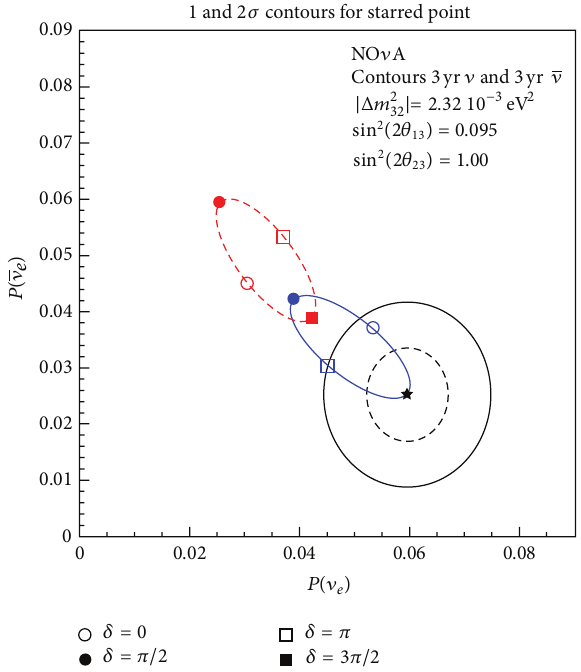
Figure 29: Biprobability plot for sin 2 (2𝜃 23 ) = 0.97 with NO 𝜈 A expected 1 and 2 standard deviation contours superimposed on the starred